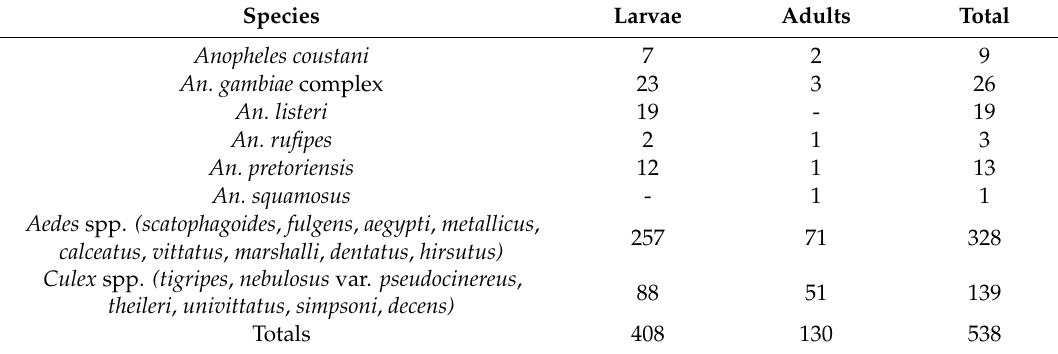
Table 4. Findings of a 1953 survey of mosquitoes in the upper Limpopo River Valley [13].